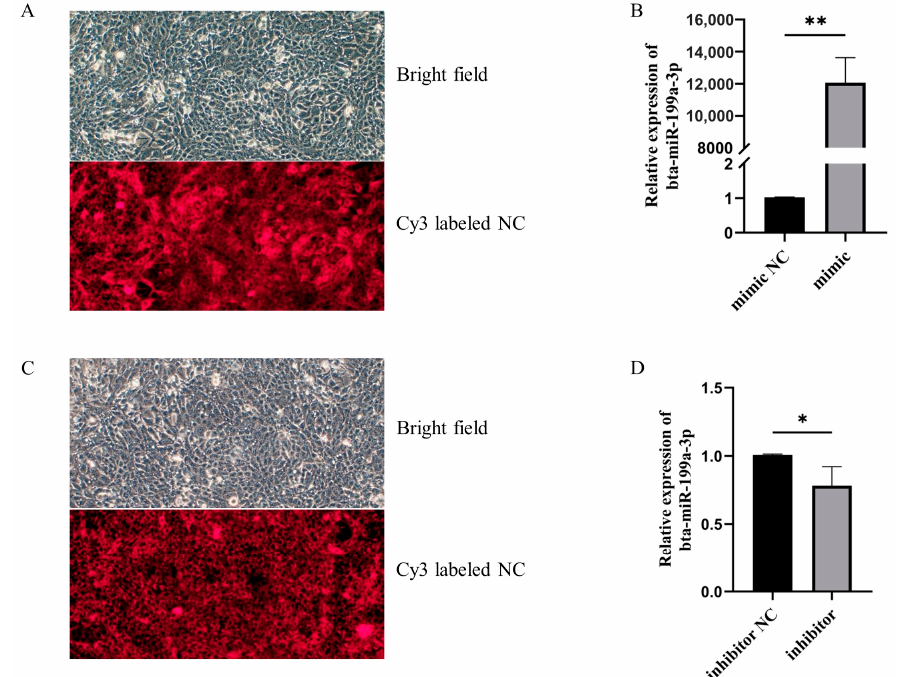
Figure 2. Transfection efficiency of bta-miR-199a-3p in the MAC-T cells. ( A , C ) The MAC-T cells were transfected with the bta-miR-199a-3p mimic (50 nM) or inhibitor (100 nM), and the transfection efficiency of the MAC-T cells was observed under an inverted fluorescence microscope. ( B , D ) The MAC-T cells were transfected with the miR-199a-3p mimic (50 nM) or inhibitor (100 nM), and the expression level of bta-miR-199a-3p was detected using qRT-PCR. GAPDH and RPS18 were used as the internal controls. * refers to p < 0.05, ** refers to p < 0.01.